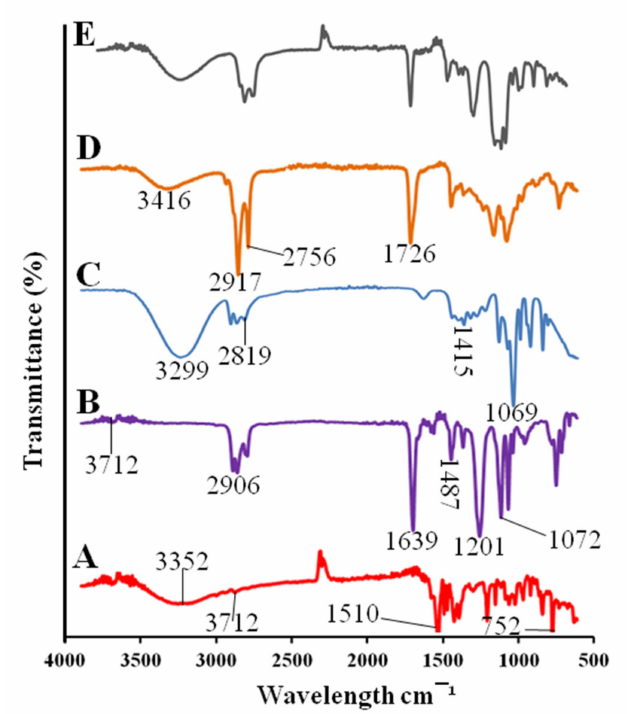
Figure 3. FTIR spectra of pitavastatin ( A ), cinnamon oil ( B ), PEG 400 ( C ), Tween 80 ( D ), drug-loaded SPC3 formulation ( E ).